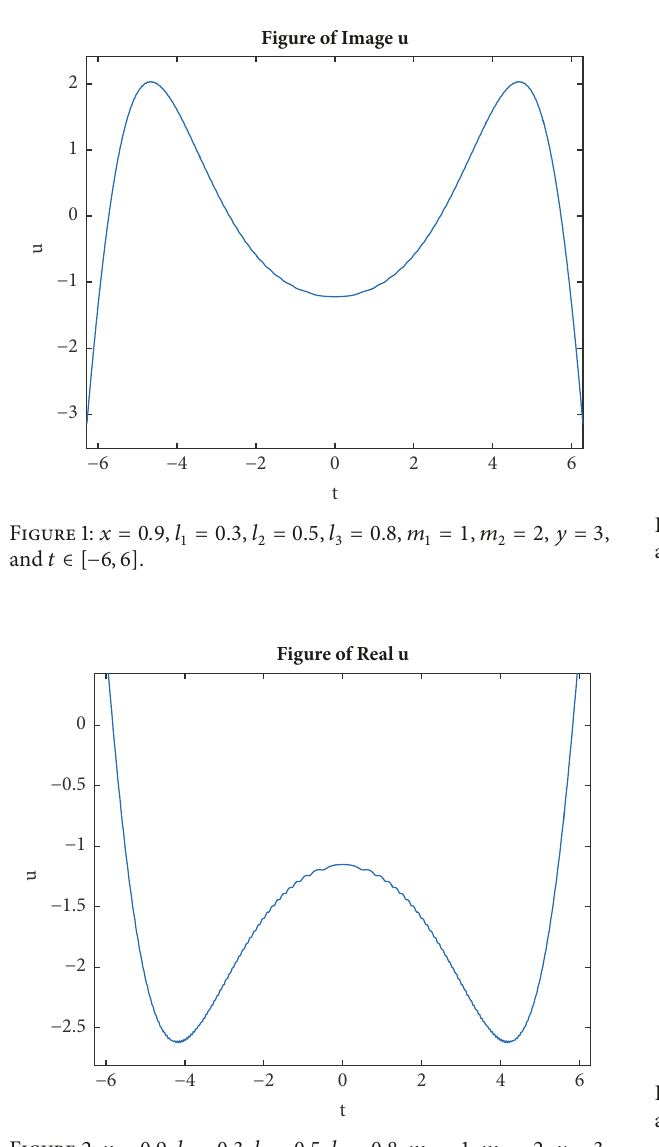
Figure 2: 𝑥 = 0.9 , 𝑙 1 = 0.3 , 𝑙 2 = 0.5 , 𝑙 3 = 0.8 , 𝑚 1 = 1 , 𝑚 2 = 2 , 𝑦 = 3 , and 𝑡 ∈ [−6,6] .